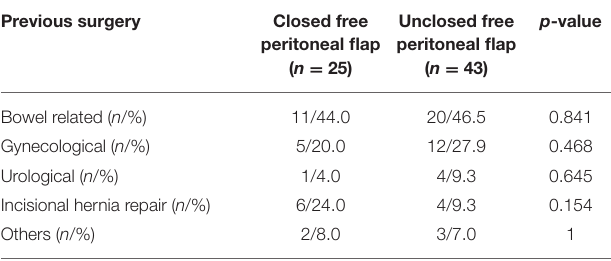
TABLE 5 | Previous surgery in patients who underwent laparoscopic hernia repair.